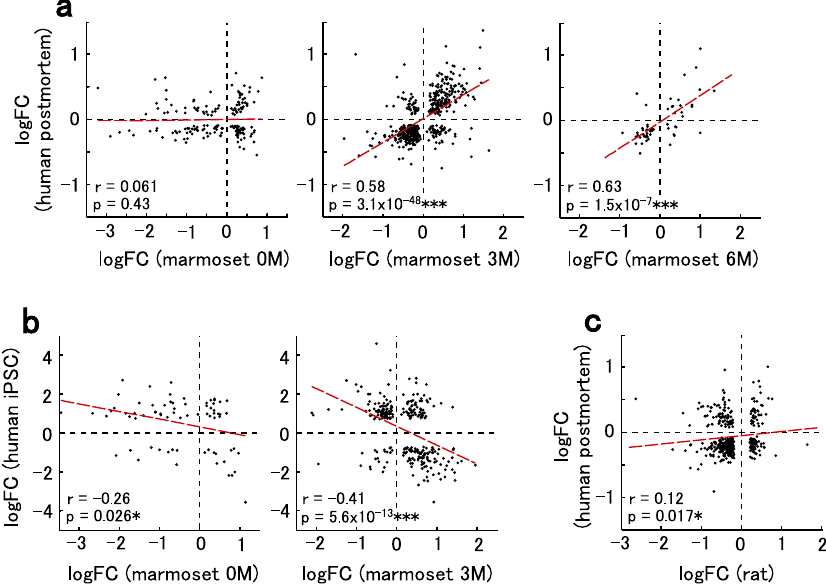
Fig. 5 Relationship between gene expression modulations in VPA-exposed marmosets and human ASD. a Relationship between the logFC values in marmosets at 0 M (left), 3 M (center), and 6 M (right), and postmortem human ASD 48 . Modulated genes with p adj < 0.1 are plotted. For each plot, Spearman ’ s correlation coef fi cients ( r ) and two-sided p -values ( p ) are shown. The dashed red line is the linear regression. *** p < 0.001. b Relationship between the logFC values in marmosets at 0 M (left) and 3 M (right) and iPSC-derived neurons from human ASD (31 days of terminal differentiation) 50 . Modulated genes with p adj < 0.1 are plotted. Spearman ’ s correlation coef fi cients ( r ) and two-sided p -values ( p ) are shown. Dashed red line is the linear regression. *** p < 0.001, * p < 0.05. c Relationship between the logFC values in VPA-exposed rats 51 and postmortem human ASD. Modulated genes with p adj < 0.1 are plotted. Spearman